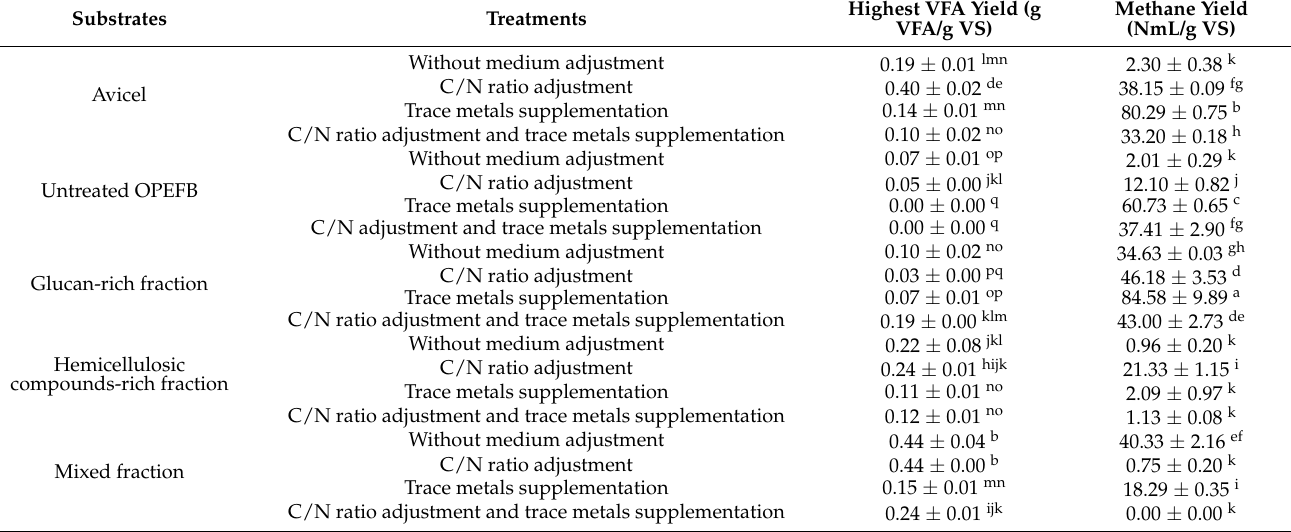
Table 2. Maximum VFAs yield from different substrates with different medium adjustments. The experiments were carried out in